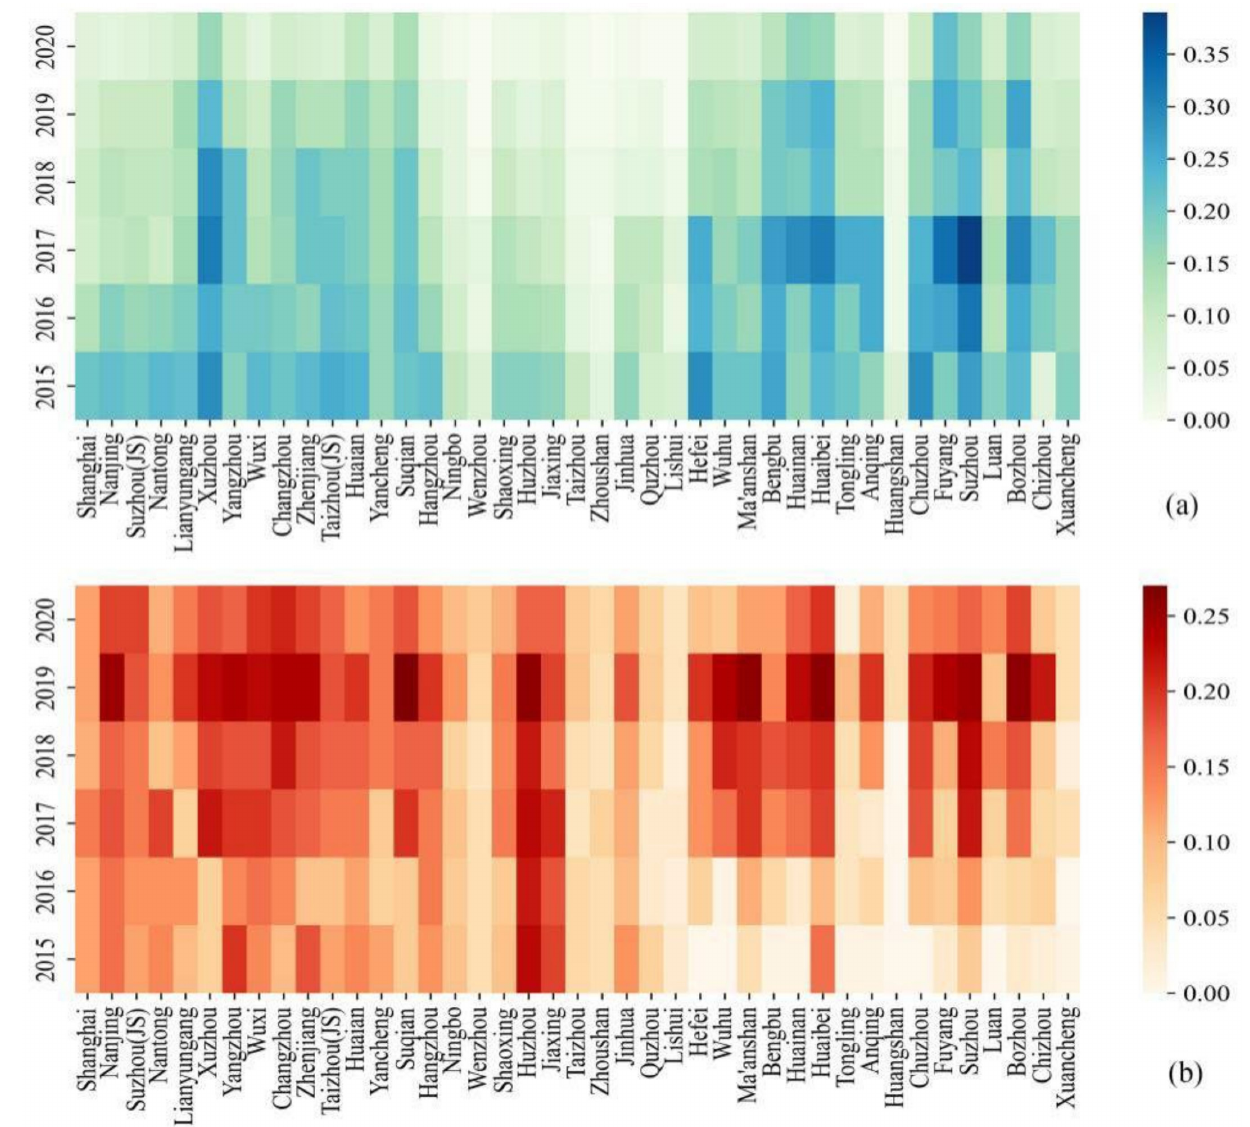
Figure 8. Annual proportion of days with pollutant concentrations exceeding the Chinese standards in 41 cities in the YRD from 2015 to 2020 (the horizontal axis, from left to right, shows Shanghai, 13 cities in Jiangsu Province, 11 cities in Zhejiang Province, and 16 cities in Anhui Province). ( a ) PM 2.5 concentrations (standard = 75 µ g/m 3 ) and ( b ) O 3 _MDA8 concentrations (standard = 160 µ g/m 3